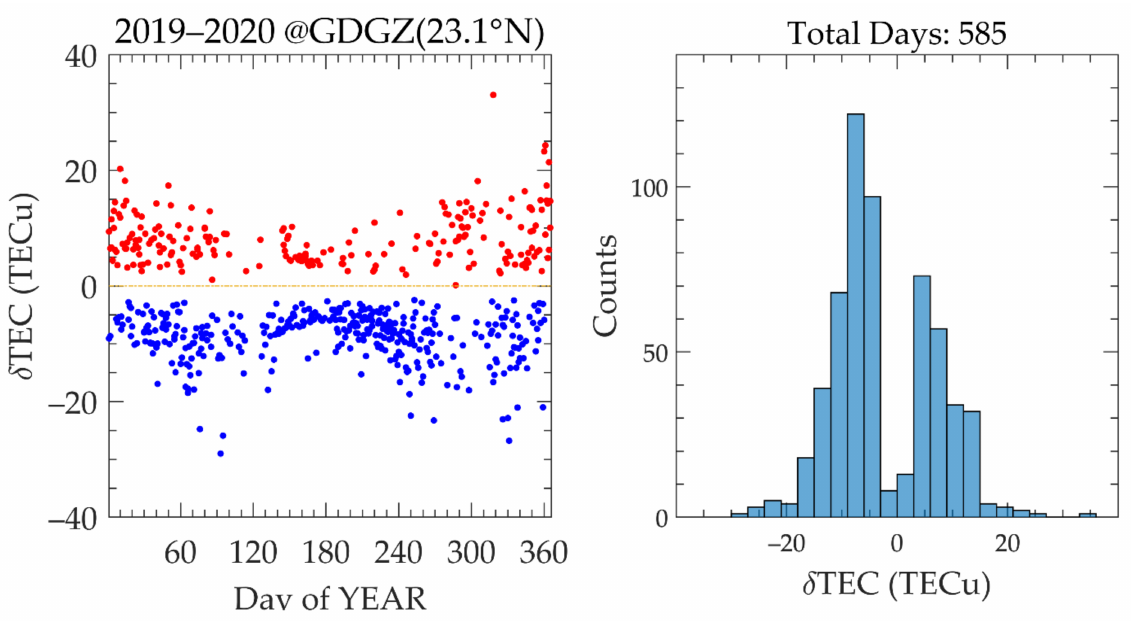
Figure 7. Seasonal variation and the histogram of δ TEC, the daily peak longitudinal difference of GEO